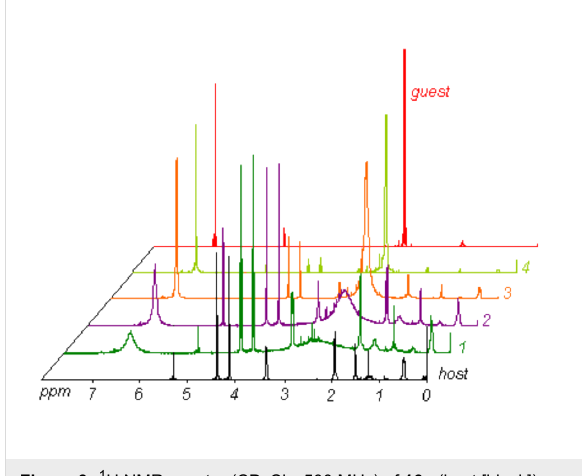
Figure 3: 1 H NMR spectra (CD 2 Cl 2 , 500 MHz) of 16c (host [black]) upon titration with N , N , N ′ , N ′ -tetramethyl- p -phenylenediamine (guest [red]); host concentration: 0.01M; host–guest ratio: 1:2 (1), 1:5 (2), 1:10 (3), 1:20